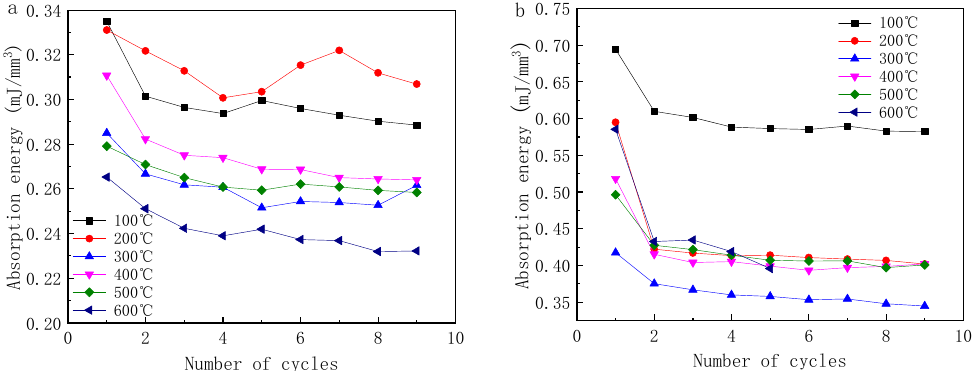
Figure 10. Variations of absorption energy of granite samples with number of temperature and stress cycles at six upper limit cyclic temperatures ( a ) upper limit of cyclic stress = 70% of UCS, ( b ) upper limit of cyclic stress = 85% of UCS.